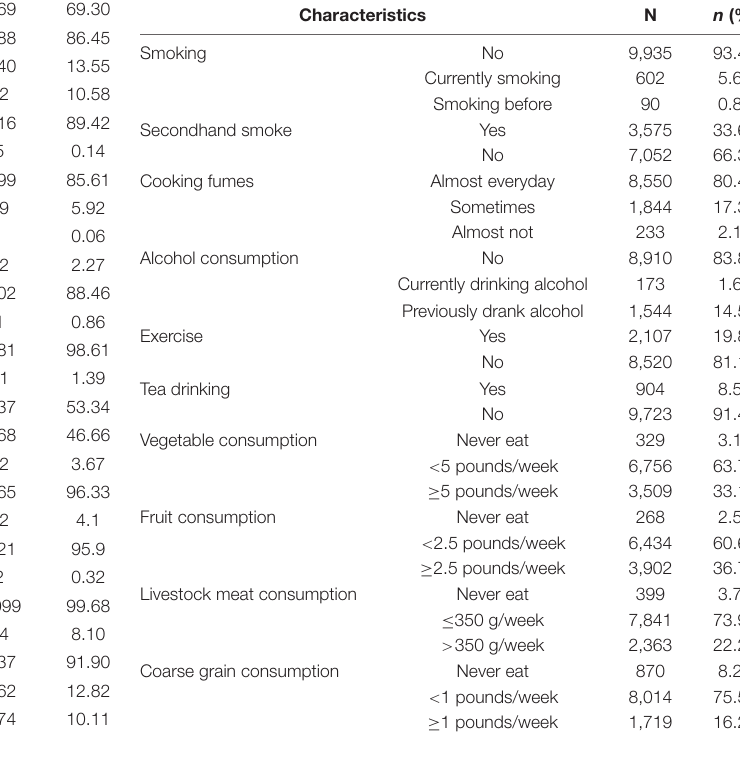
TABLE 3 | Living conditions of cervical cancer screening